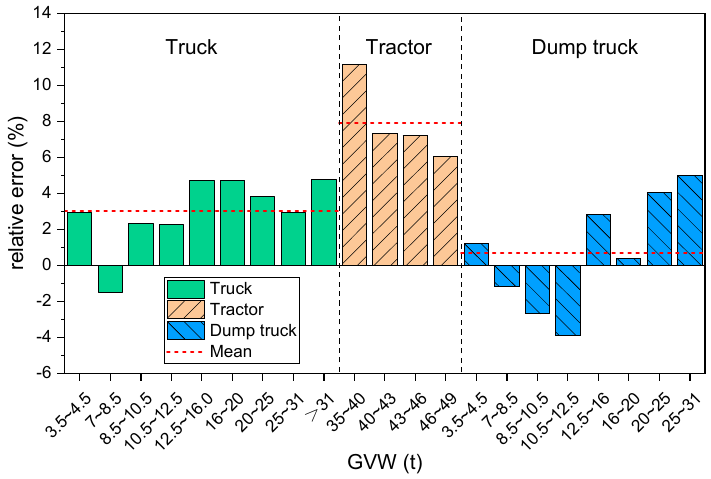
Figure 13. Relative errors between average fuel consumption and the China fourth stage limits.